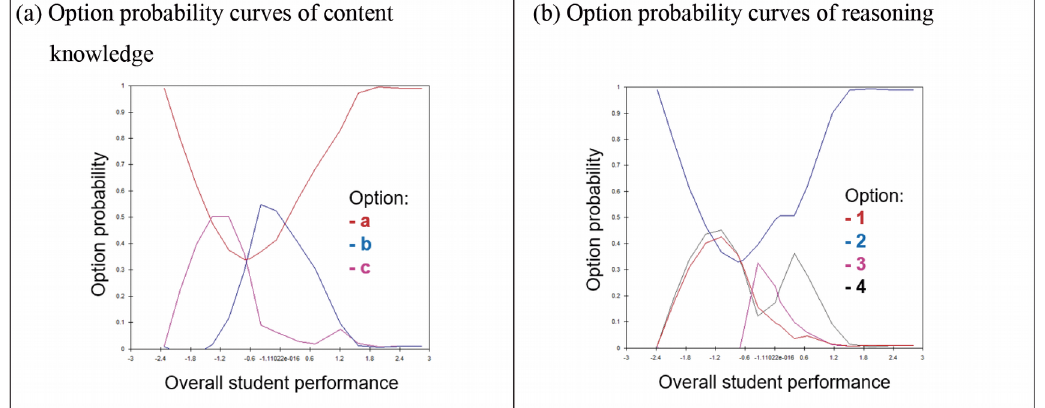
Figure 6. Corresponding option probability curves of (a) content knowledge and (b)